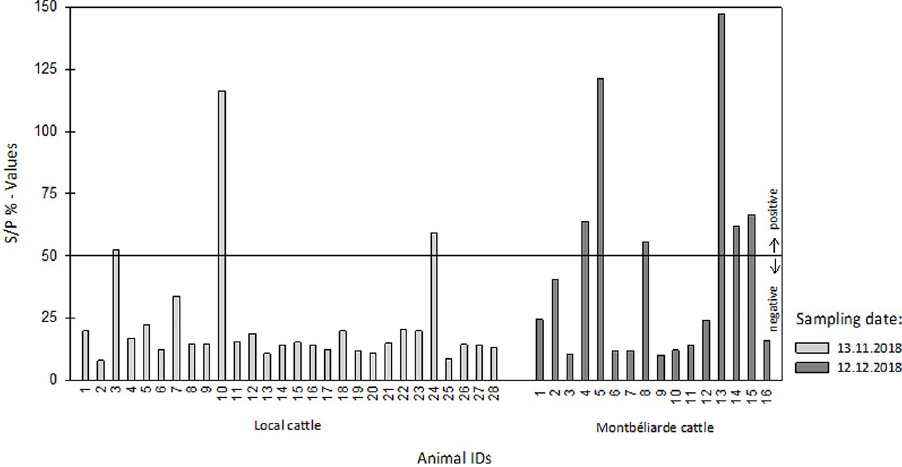
Fig 4. IgM Capture ELISA. S/P % = corrected optic density sample / corrected optic density positive control x 100.